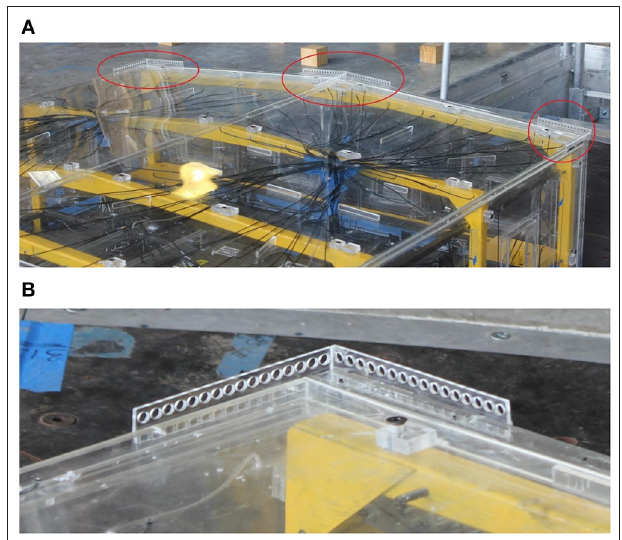
FIGURE 4 | (A) Location of the parapets on the test model, and (B) Detailing of the perforated parapet ( L